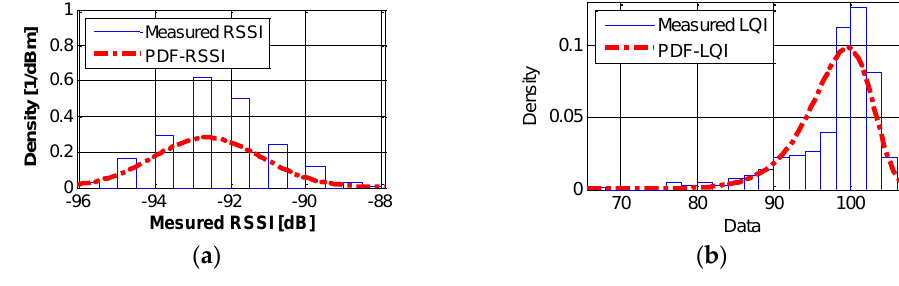
Figure 6. Histogram and suggested PDFs: ( a ) RSSI; and ( b ) LQI.